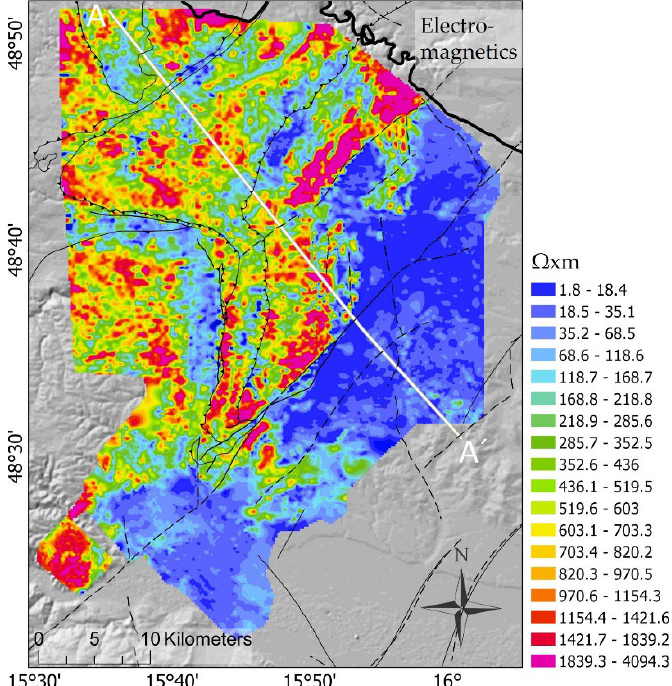
Figure 3. Apparent electrical resistivity map in ohm-meter ( Ω × m). Location of profile A (white line) is shown for orientation, black lines indicate geological faults, see legend in Figure 1b for details. Background map: Lidar image with a 10 × 10 m resolution.